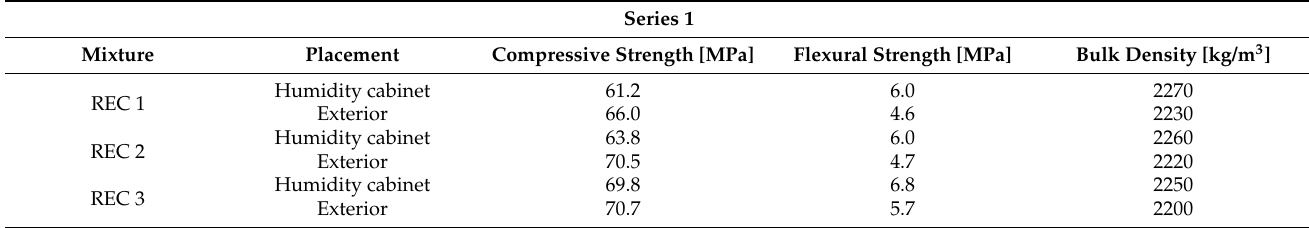
Table 5. Results of basic physical and mechanical properties for Series 1.